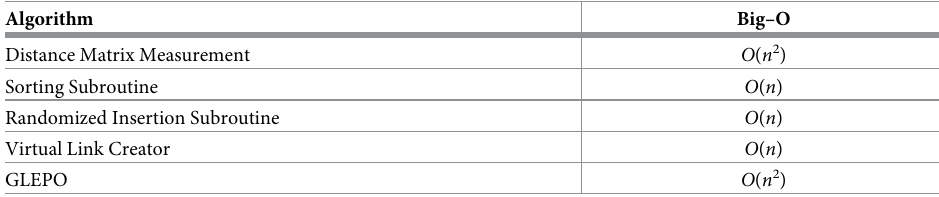
Table 1. Computational complexity of various algorithms in the pipeline.